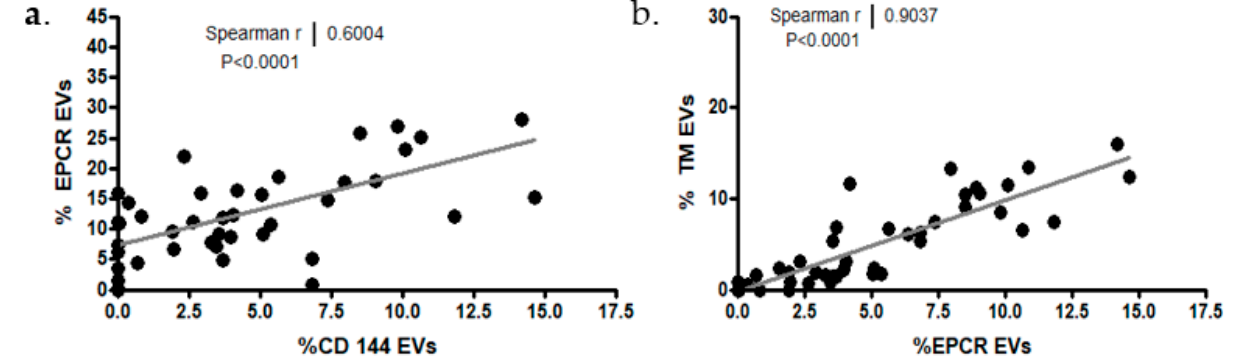
Figure 4. EV platelet markers and coagulation factors . The expression of platelet and activated platelet markers (( a ) CD41, ( b ) CD62P) on EVs derived from PPP of HCs and mild, moderate, and severe COVID-19 patients, and coagulation antigens, were measured using a CytoFLEX LX flow cytometer. Data are expressed as percentage of labeled EVs in the EXo gate (as described in Figure 2a). Percentages of PPP EVs expressing the procoagulant antigen and tissue factor (TF, CD142) were measured using a CytoFLEX LX flow cytometer ( c ). EV pellet TF activity was measured by a TF Chromogenic Activity Assay Kit (ab108906) ( d ). Percentage of the anticoagulant proteins: endothelial protein receptor (EPCR) and thrombomodulin (TM, CD141) on EVs derived from PPP were measured using a CytoFLEX LX flow cytometer ( e , f ) * p <0.05, ** p <0.01. High correlations were found in all patients’ EPCR and TM EVs (R = 0.9037; p < 0001) and between the percentages of EPCR-expressing EVs and CD144-expressing EVs (R = 0.6004; p < 0001) (Figure 5a,b).